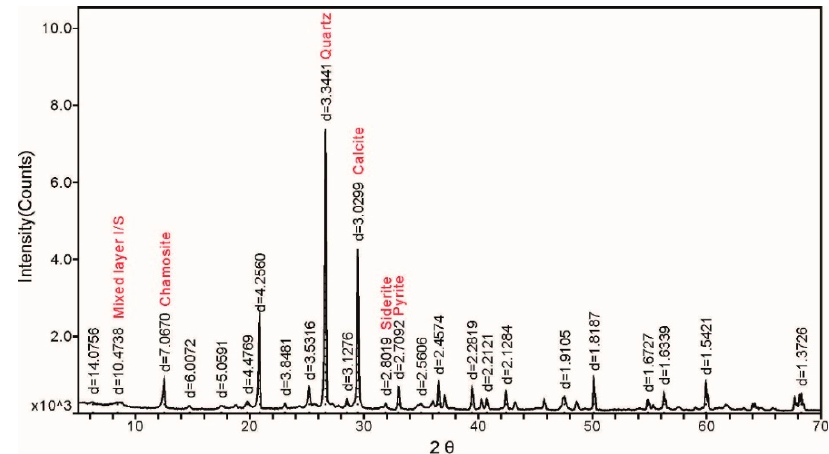
Figure 4. Identification of minerals in the XRD pattern of the low temperature ashes (LTA) of the